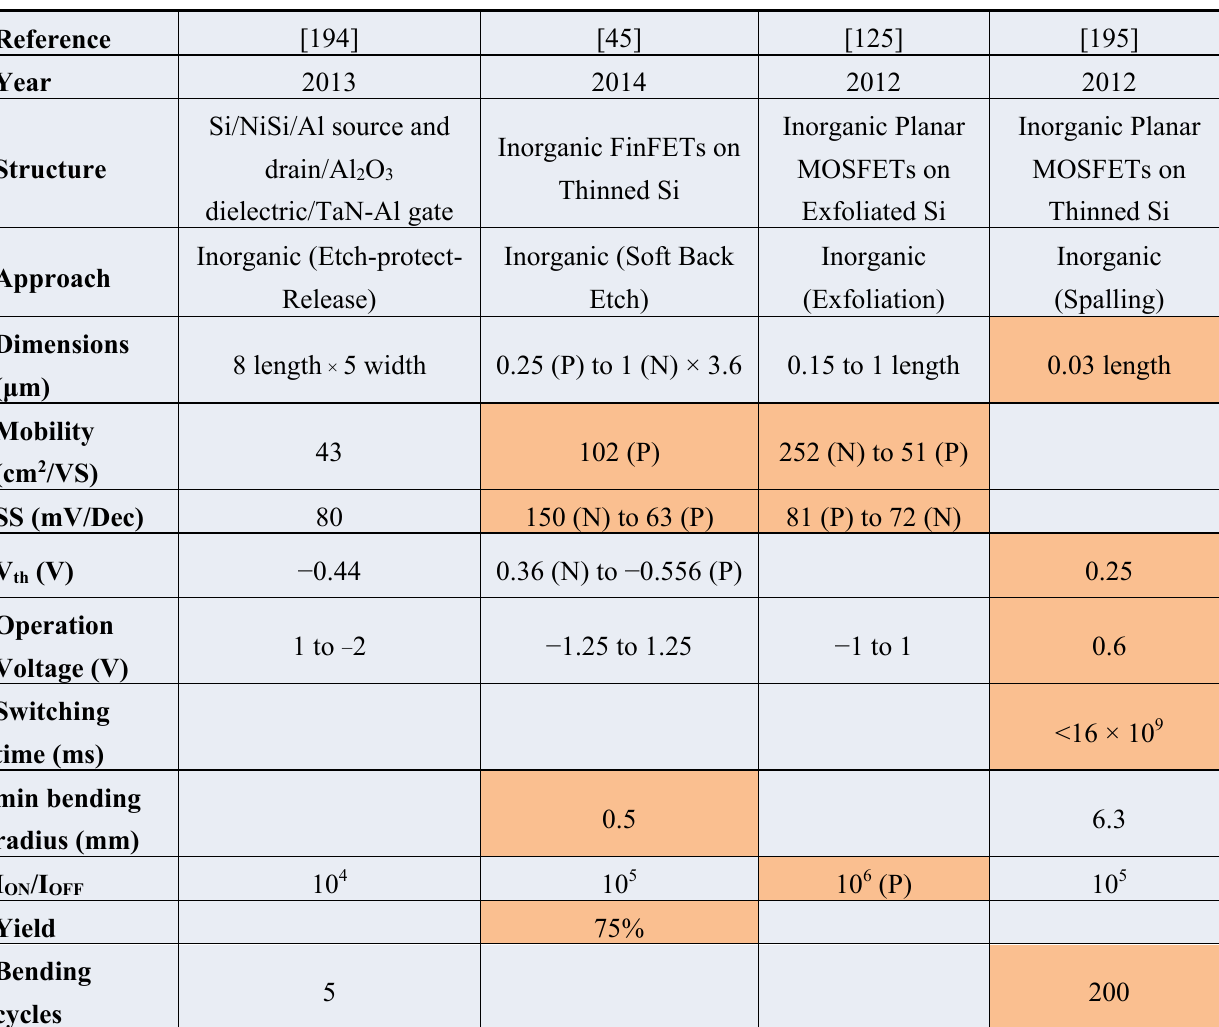
Table 4. Works on flexible inorganic field effect transistors (FETs) between January 2010 and May